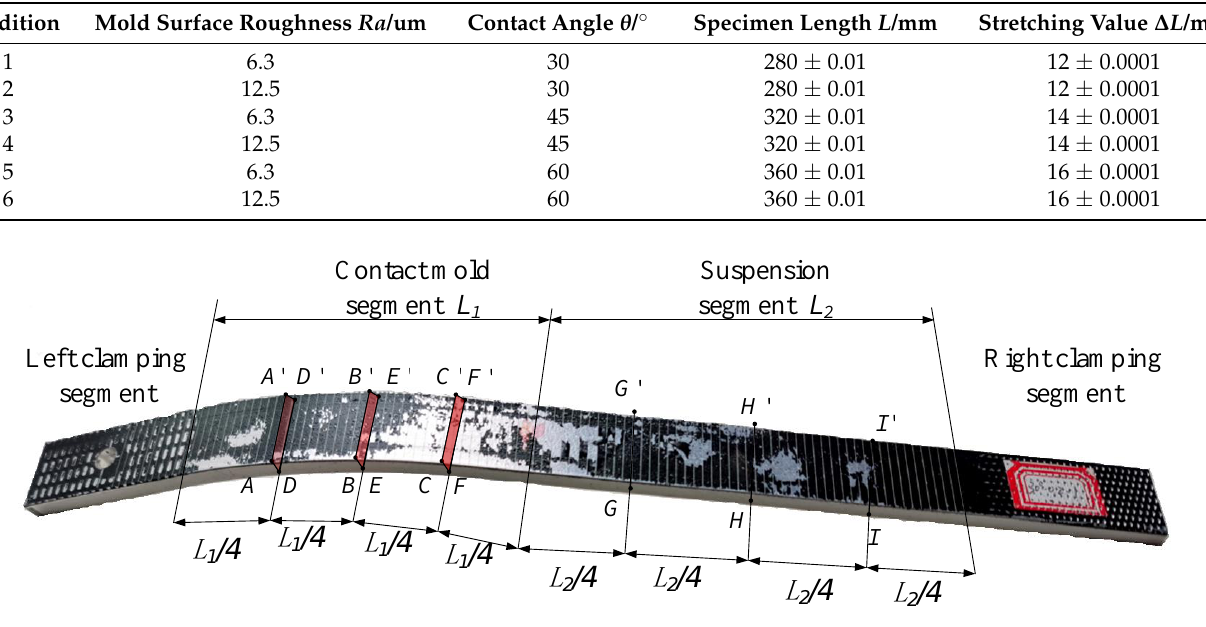
Figure 10. The specimen after stretch-bending.